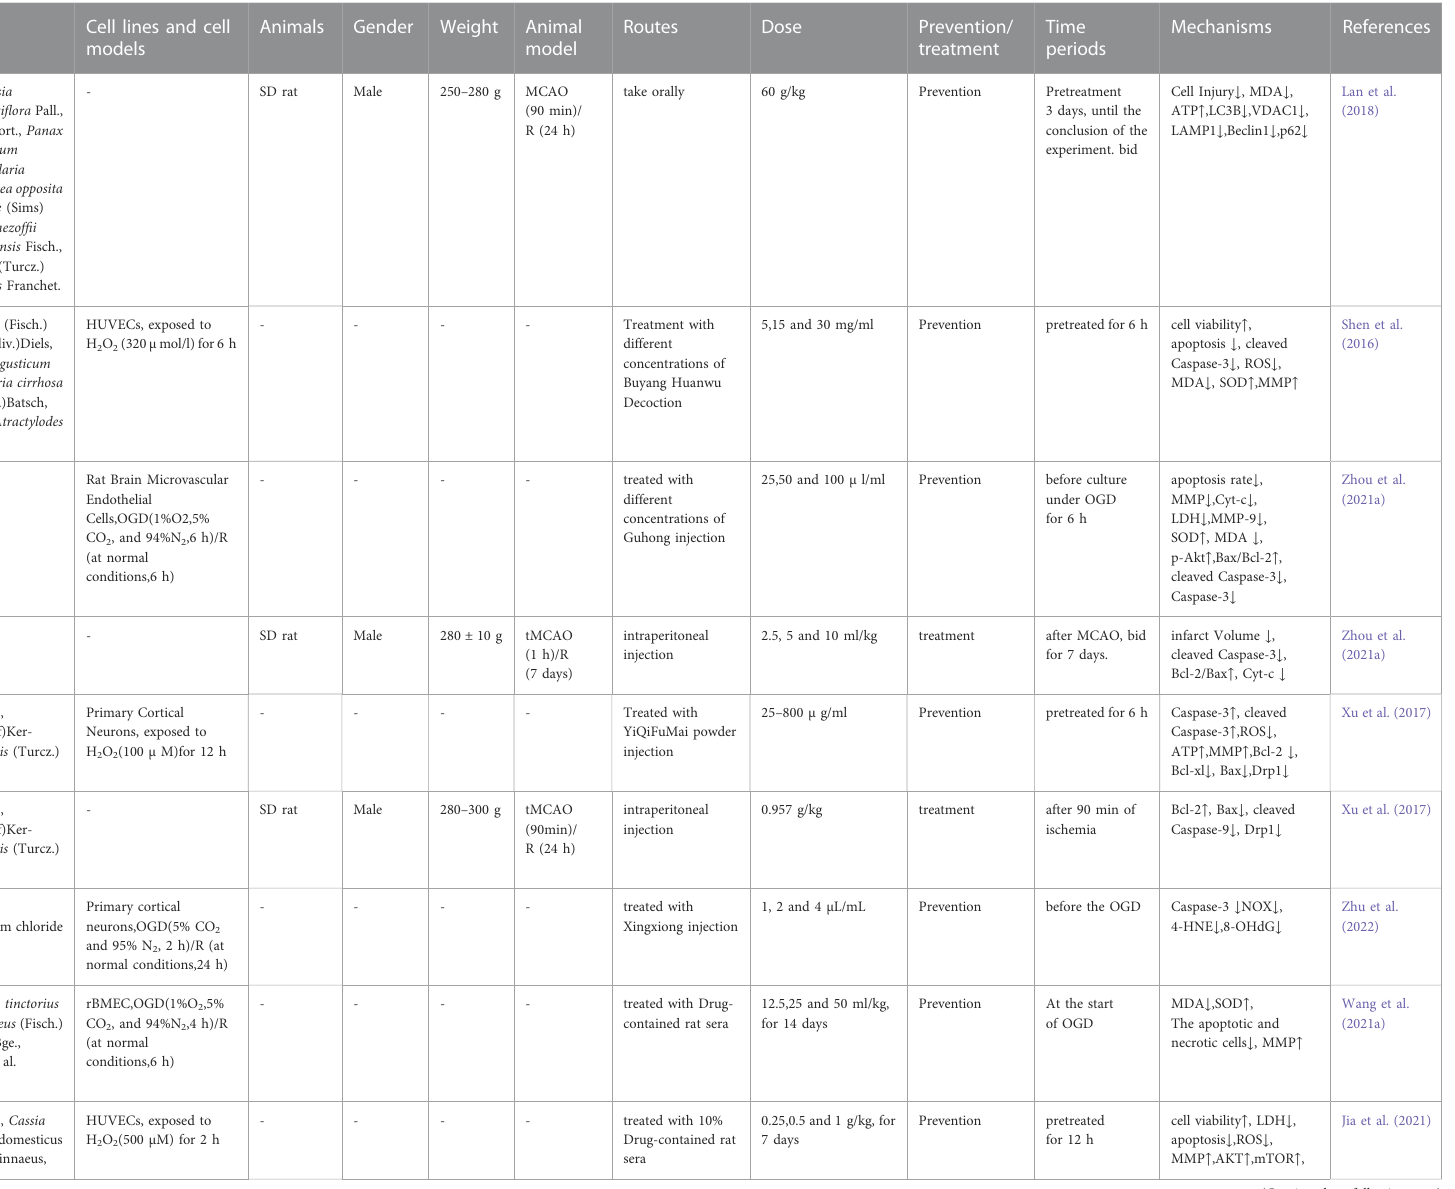
TABLE 4 The molecular mechanism of TCM prescription in the treatment of ischemic stroke by targeting mitochondria. Agents Ingredients Cell lines and cell